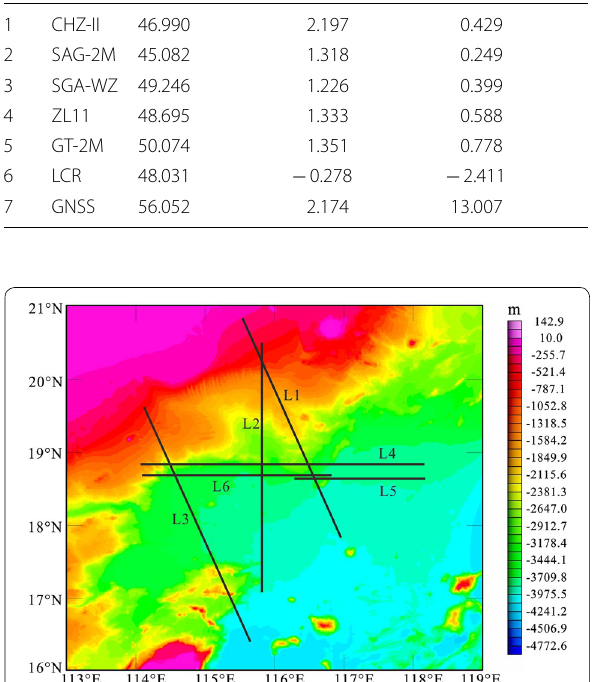
Fig. 3 Bathymetry of the area and distribution of effective measured